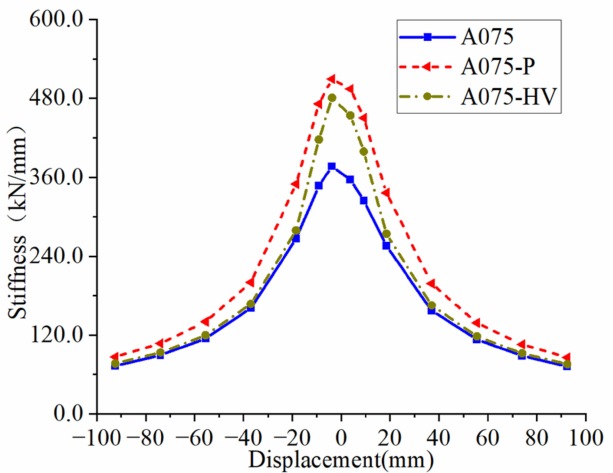
Figure 17. Stiffness degradation of different SPSWs.